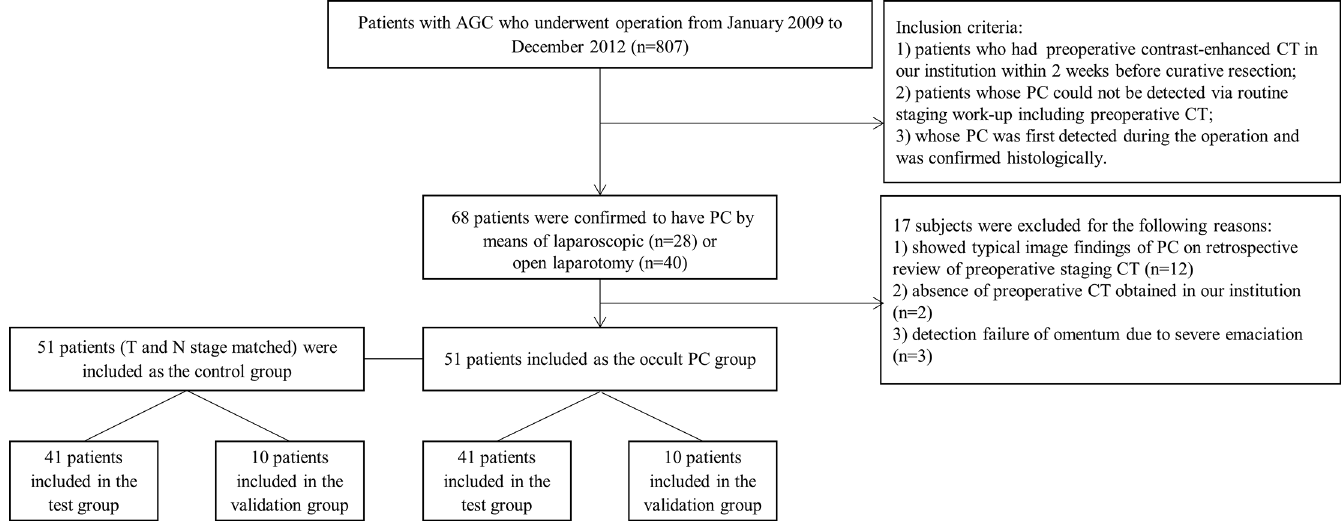
Fig 1. Flow chart showing the patient selection and exclusion.